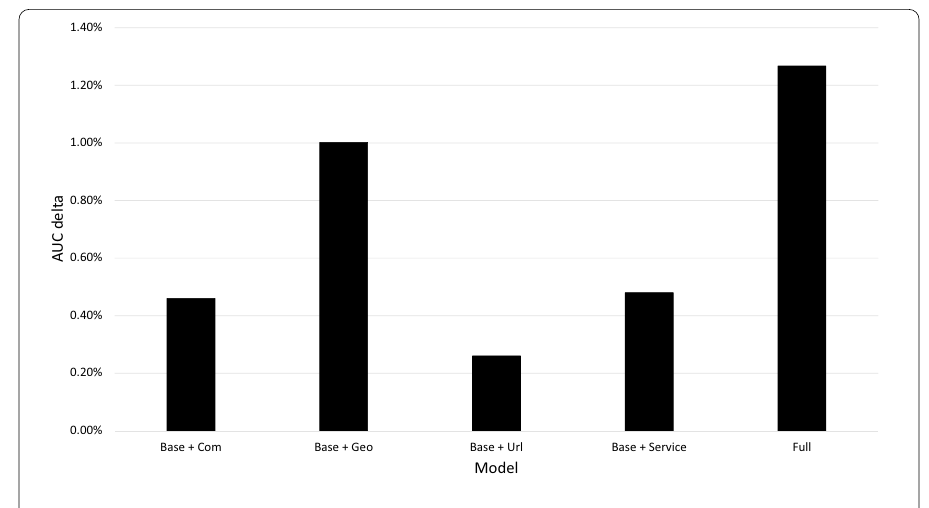
Fig. 1 Incremental AUC value by fine-grained data source for RF (500